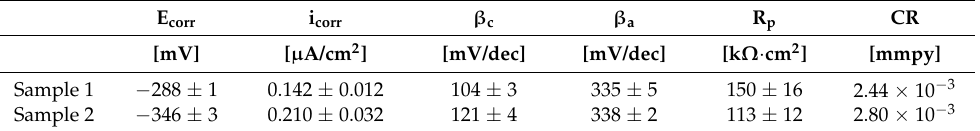
Table 5 . Electrochemical parameters obtained from Tafel curves.